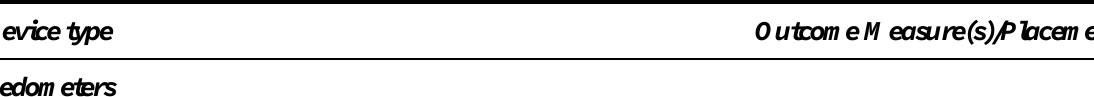
Table 2. Body fixed sensors with their properties and